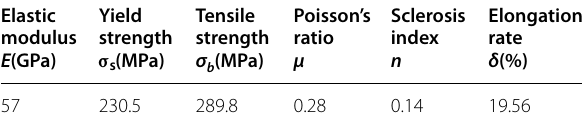
Table 1 Parameters of the 6063-T6 aluminum alloy tube